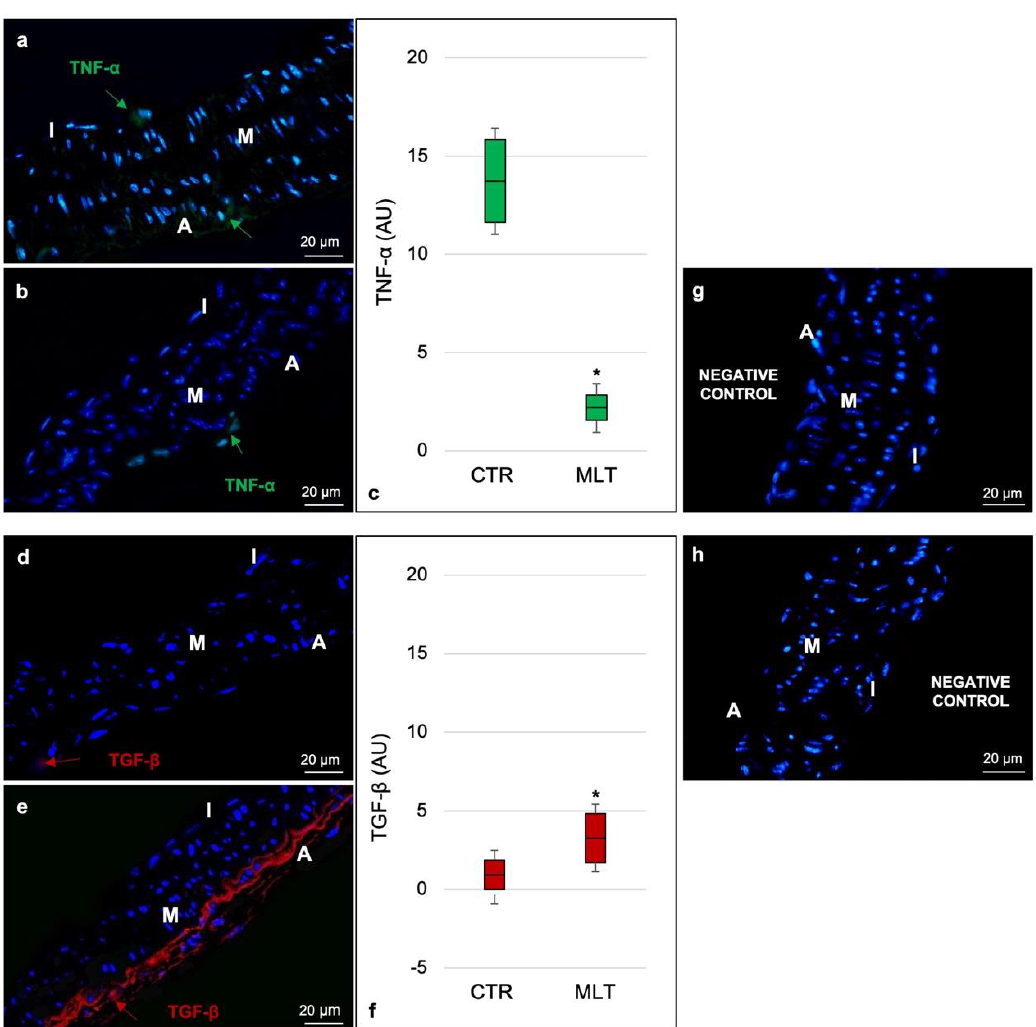
Figure 4. Immunofluorescence characterization of macrophage cytokine production. Labelling of the aorta’s wall with TNF- α ( a , b ) and TGF- β ( d , e ) antibodies. Each panel shows a full-field image at 400× (scale bars: 20 µ m). Immunofluorescence photomicrograph of control mice showed a moderate TNF- α expression at the subendothelial and adventitia levels, confirming that these mice were characterized by an infiltrate of macrophages predominantly polarized in the M1 direction ( a ). In contrast, theimmunofluorescencephotomicrographofApoE - / - micetreatedwithmelatoninhighlights, for the same M1 marker, an absent / very weak positivity ( b ). Immunofluorescence photomicrograph also showed an absent expression of TGF- β in the aorta of the control mice ( d ). Di ff erently, the immunofluorescence photomicrograph of MLT-treated mice showed a moderate TGF- β expression in the tunica adventitia ( e ). Graphs summarize, as arbitrary units, the immunomorphometrical analyses of TNF- α ( c ) and TGF- β ( f ) obtained, for both pro-inflammatory markers, evaluating fifteen non-overlapping fields with the same area for each experimental animal, respectively. For both TNF- α ( g ) and TGF- β ( h ), sections without primary antibody and in the presence of isotype matched immunoglobulins G served as negative immunofluorescence controls. Statistical analyses comparing multiple continuous outcomes were performed using one-way analyses of variance test corrected by Bonferroni for immunomorphometrical evaluations. Continuous variables are summarized as means ± standard deviation. Error bars represent the 95% confidence interval around the mean; * indicates the level of significance, p ≤ 0.05; red arrows indicate the positive staining for TNF- α ; green arrows indicate the positive staining for TGF- β ; I, tunica intima; M, tunica media; A, tunica adventitia; CTR, control group; MLT, mice treated with melatonin; AU, arbitrary